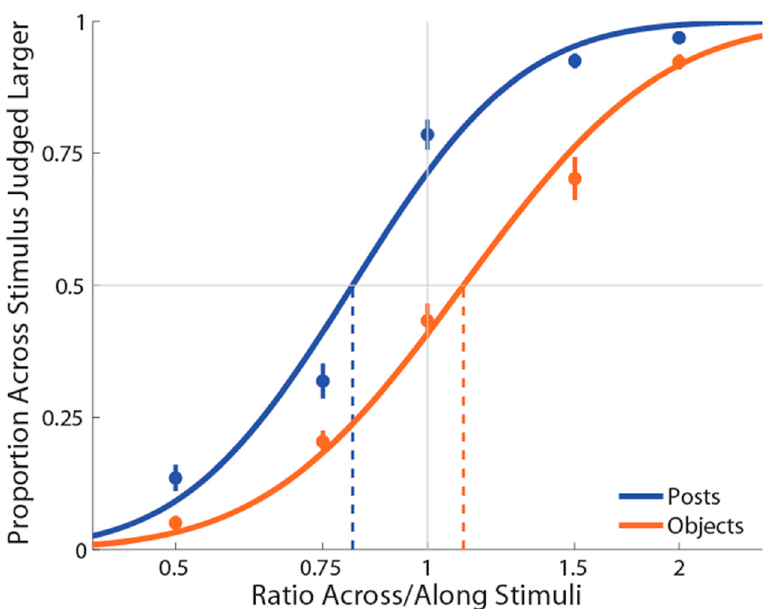
Figure 2. Experiment 1 results in which curves (blue for posts stimulations and orange for objects stimulations) are the cumulative Gaussian functions fit with least-squares regression. Vertical lines represent points of subjective equality (i.e., where the curve crosses 50%). Error bars represent the standard error of the mean (±SEM).